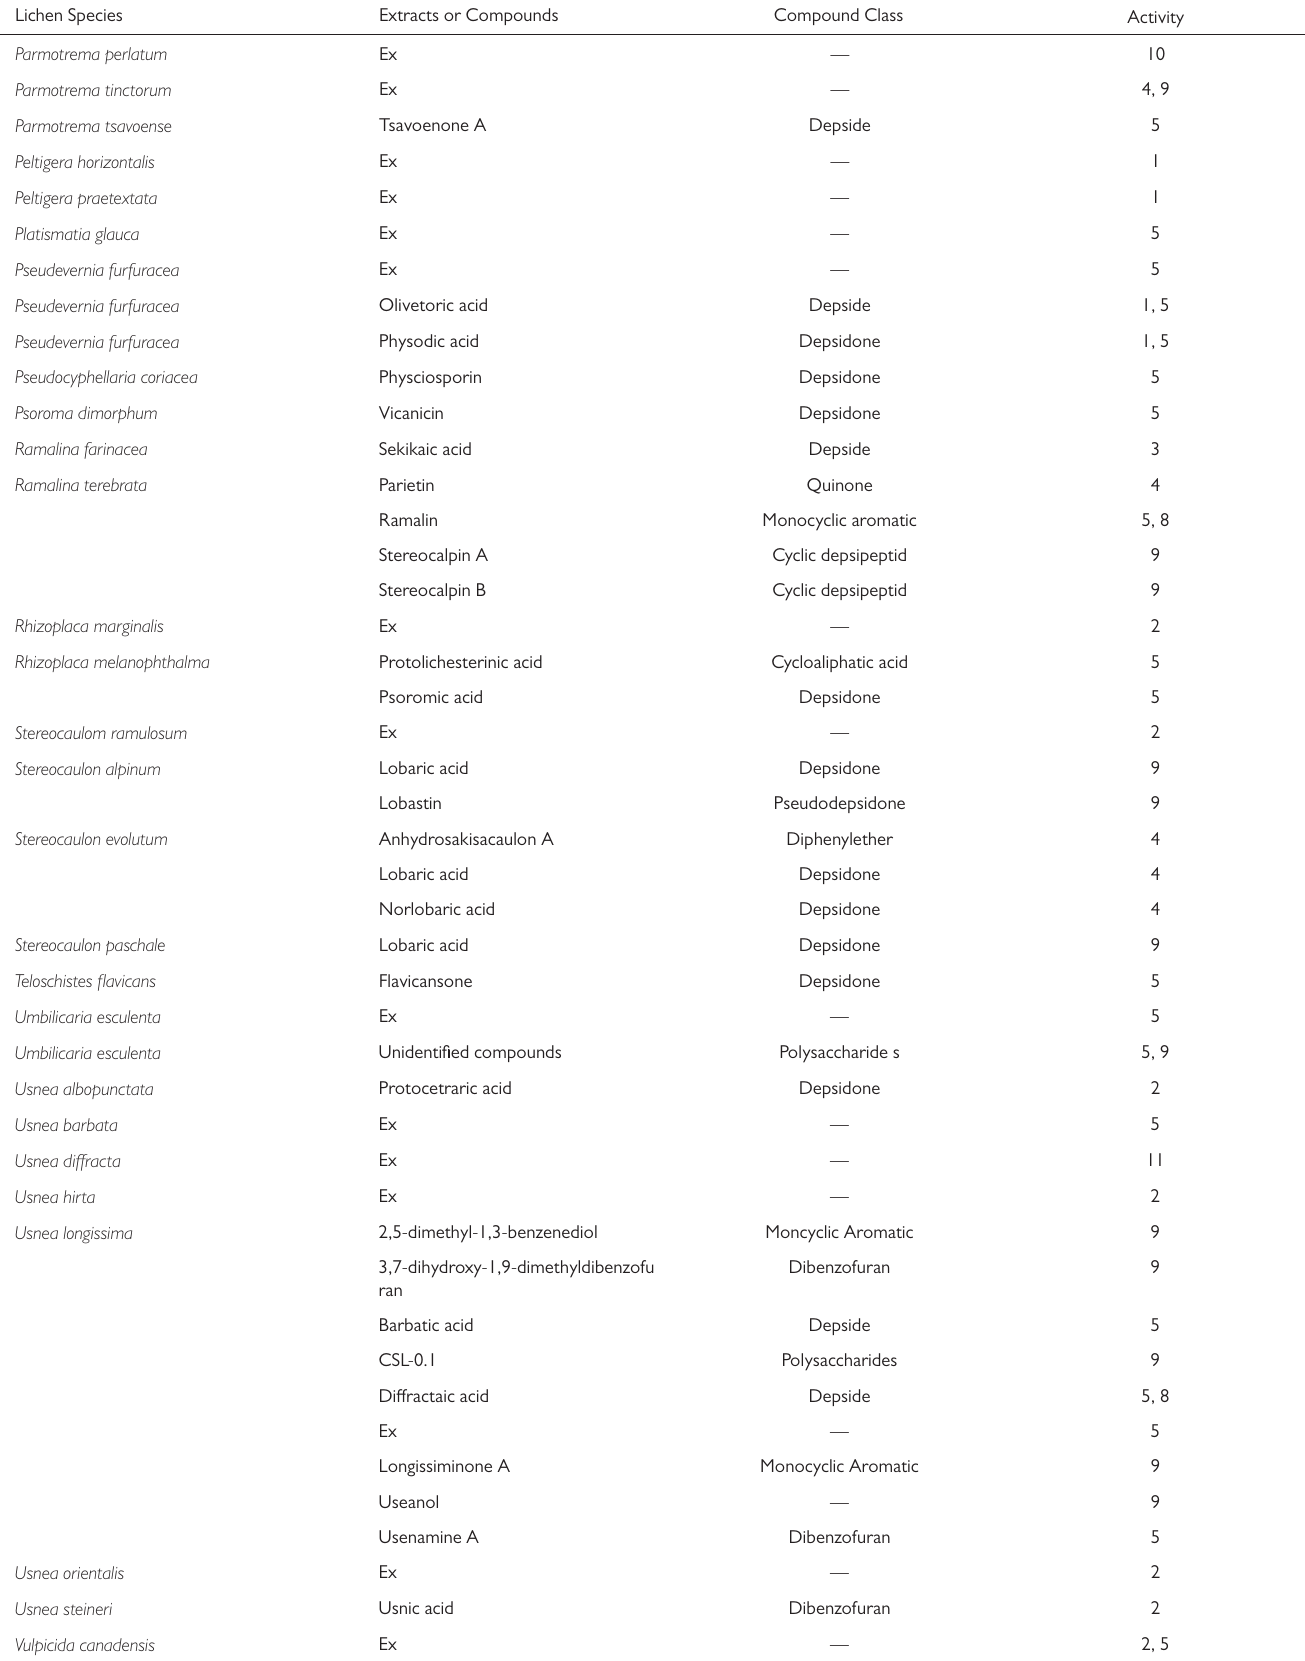
Table 1. Summary of Pharmacological Activities of Lichen-Derived Extracts and Compounds ( Continued